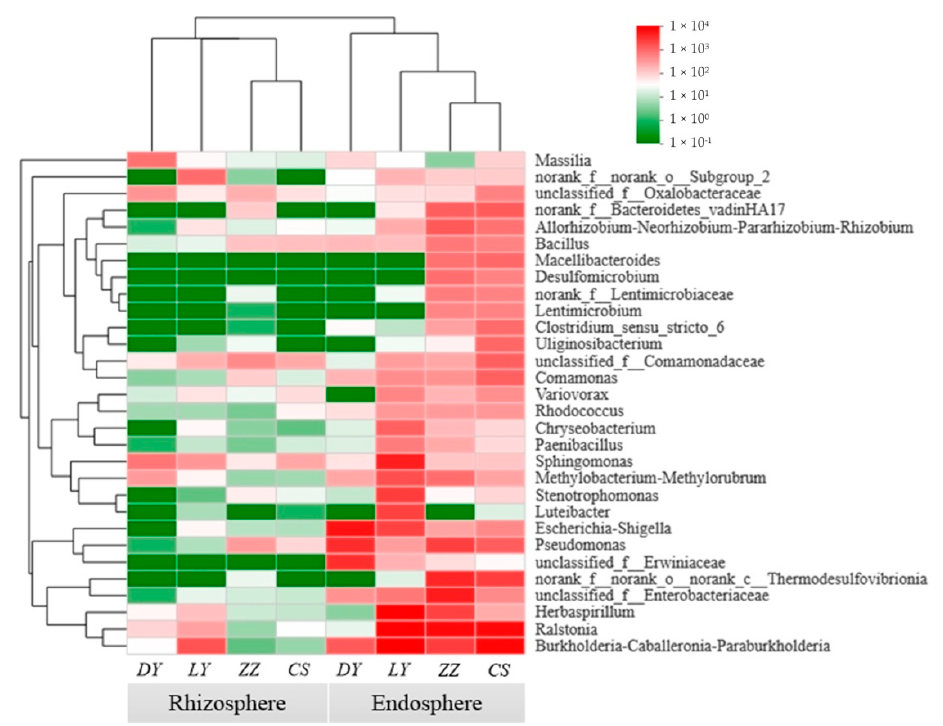
Figure 4. Heat map analysis of the dominant genera (top 30) distribution in the endosphere and rhizosphere of C . communis. The abundance is expressed as the color intensity, which reflects the proportion of the total effective sequences in each group.